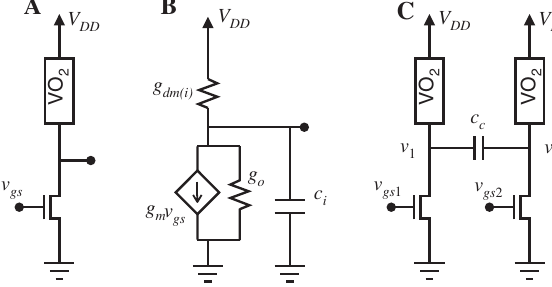
Figure 3: (A) Oscillator circuit with MOSFET in series with a VO device. (B) Small signal equivalent circuit of the oscillator with VO in series with a MOSFET. (C) Coupled oscillator circuit with a series MOSFET in place of a series resistance.